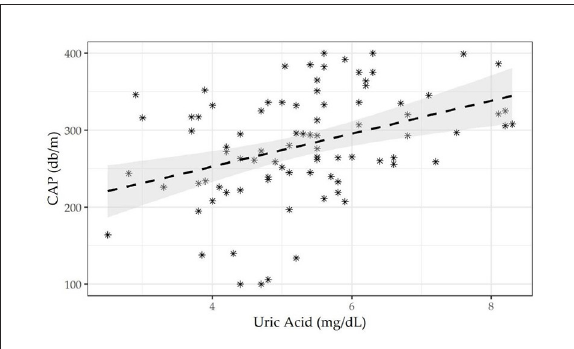
FIGURE2 Linear correlation between Controlled Attenuation Parameter (CAP) and serum uric